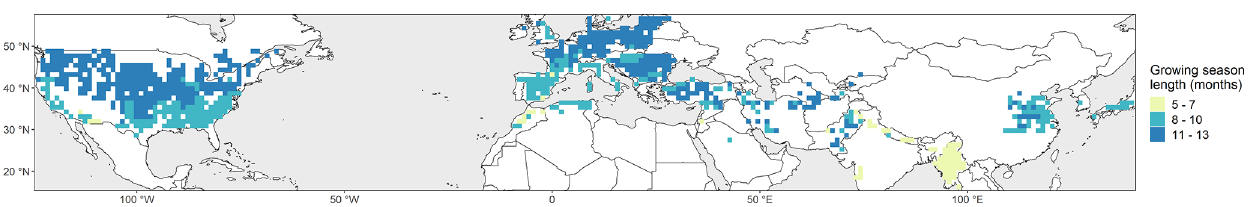
Figure B4. Number of months in the growing season (number of months between the earliest sowing date and the latest harvest date). The growing season starts at the month containing the sowing date and ends with the month containing the latest harvest date among the 1600 model years. We discarded years with harvest date later than 365 days after the sowing date. Some growing seasons are 13 months long because we include both the entire first month and the entire last month.